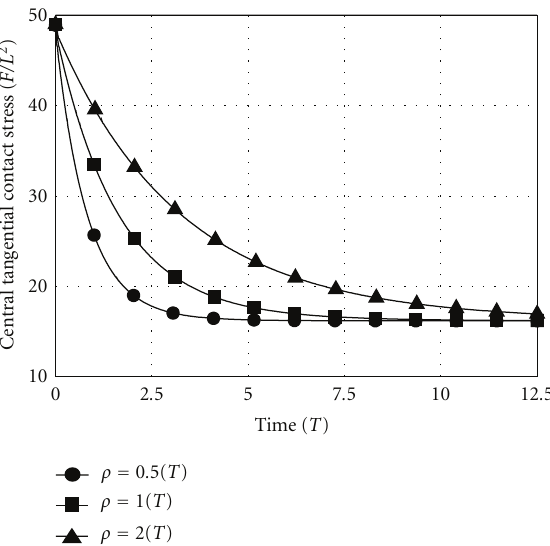
Figure 18: E ff ect of ρ on relaxation of the central tangential contact stress.